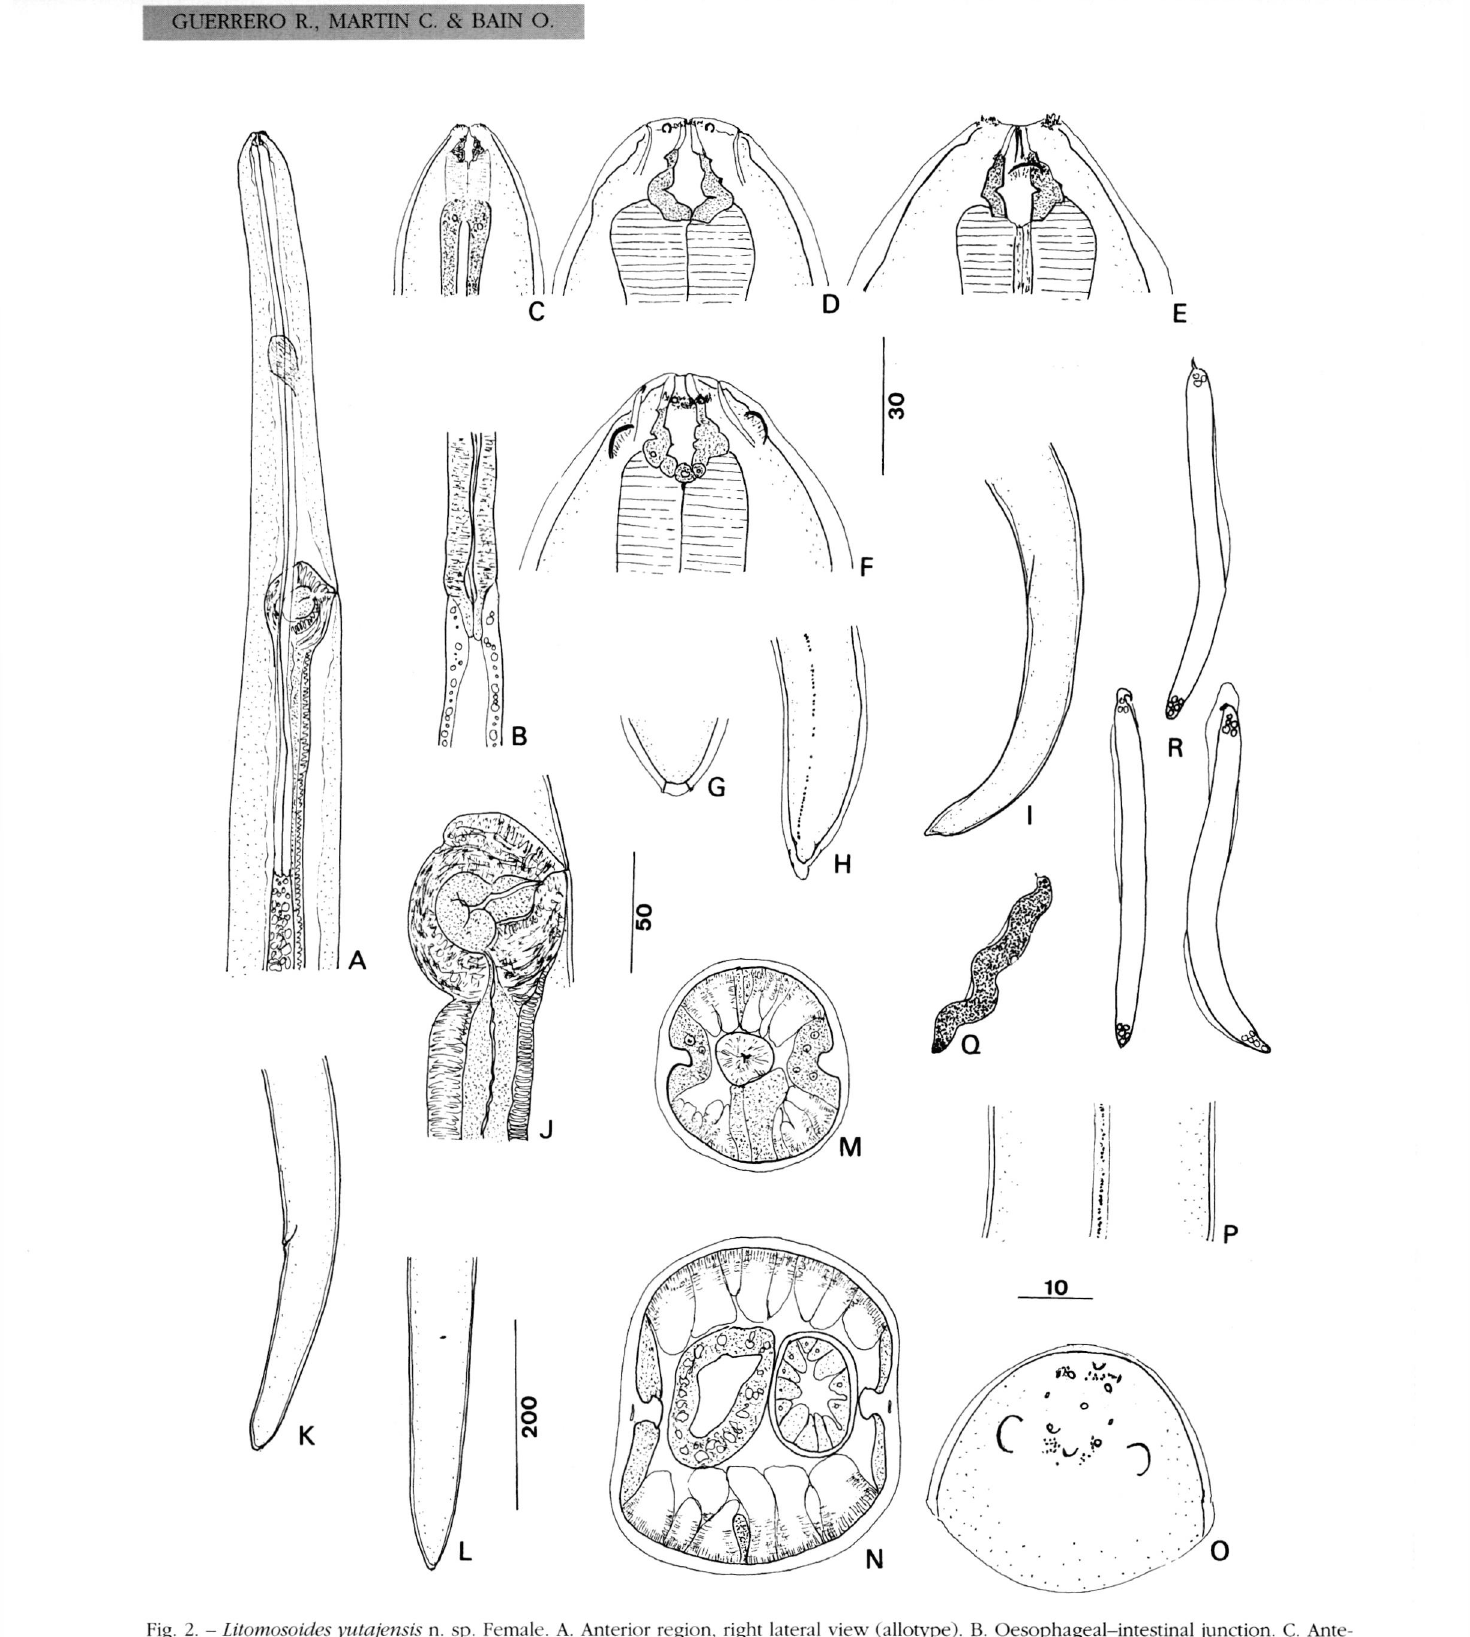
Fig. 2. - Litomosoides yutajensis n. sp. Female. A. Anterior region, right lateral view (allotype). B. Oesophageal-intestinal junction. C. Ante rior extremity, lateral view (allotype). D. Head, dorsal view (allotype). F, F. Head, right lateral and ventral views, respectively (paratype). G. Caudal extremity, ventral view. H. Caudal ornamentation of tail, left lateral view. I. Tail, lateral view (allotype). J. Vagina, right lateral view. K, L. Tail of a paratype, left lateral and ventral view, respectively. M. Cross section at level of oesophagus. N. Cross section, poste rior to vagina. O. Head, semi-apical view. P. Lateral cuticular ornamentation, 700 pm from tail. Q. Microfilaria from a thick blood smear (type host). R. Three microfilariae extracted from uteri (paratype). Scales in pm: A. I, K, L, 200; B, C, G, Q, 30; D, E, F, O, R, 10; H, J, M, N, P,